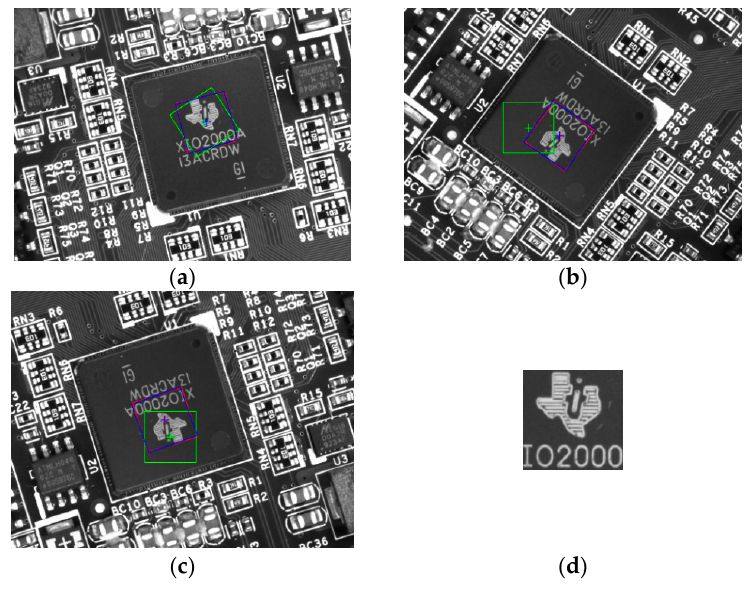
Figure 16. Printed circuit board (PCB) case1 images. ( a – c ) real and ( d ) template image (200 × 200 pixels).